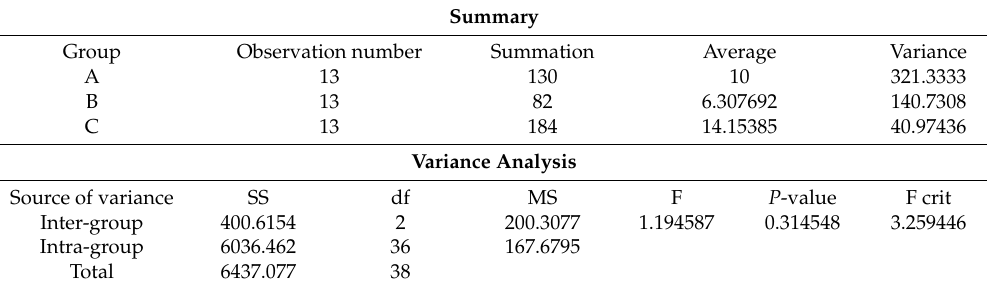
Table 3. Variance analysis of inside surface